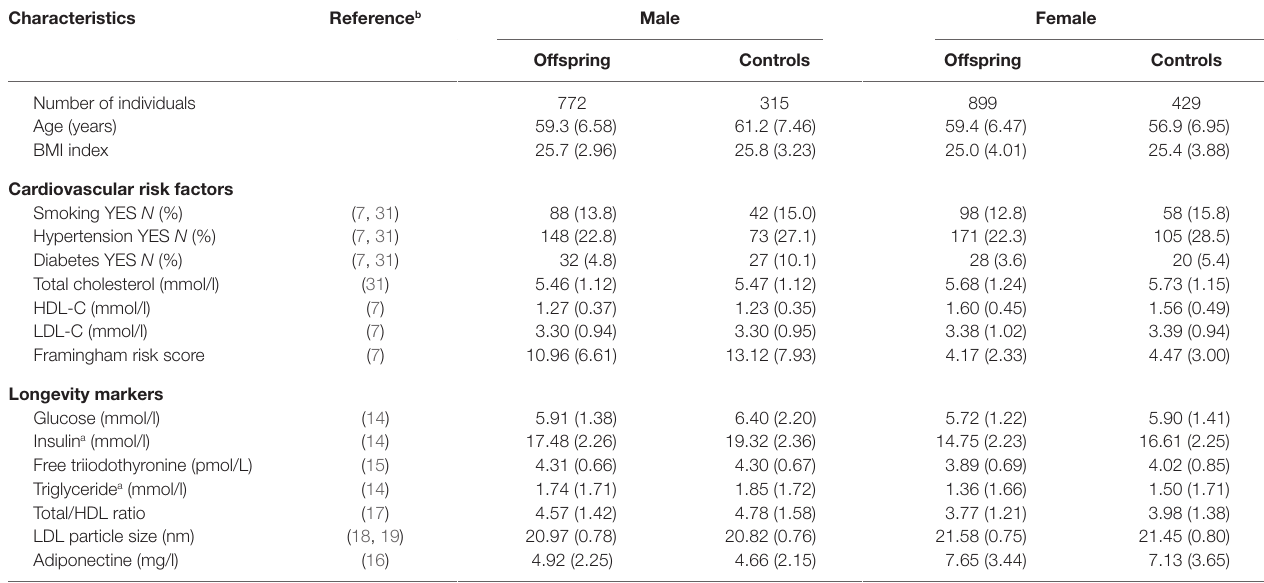
TaBle 1 | characteristics of study population (mean and sD between brackets) stratified by sex and offspring-control allocation.